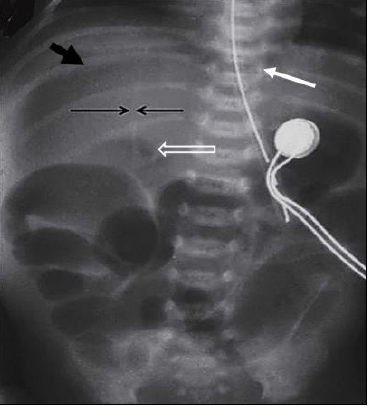
Figure 6: A case of gastric perforation showing pneumoperiton- eum. Thick black arrow showed gas in front of liver making it lucent. Thin small arrows captured ligamentum teres. White arrow showed gas under central tendon (cupola sign). Hollow white arrow showed gas in Morrison’s pouch.